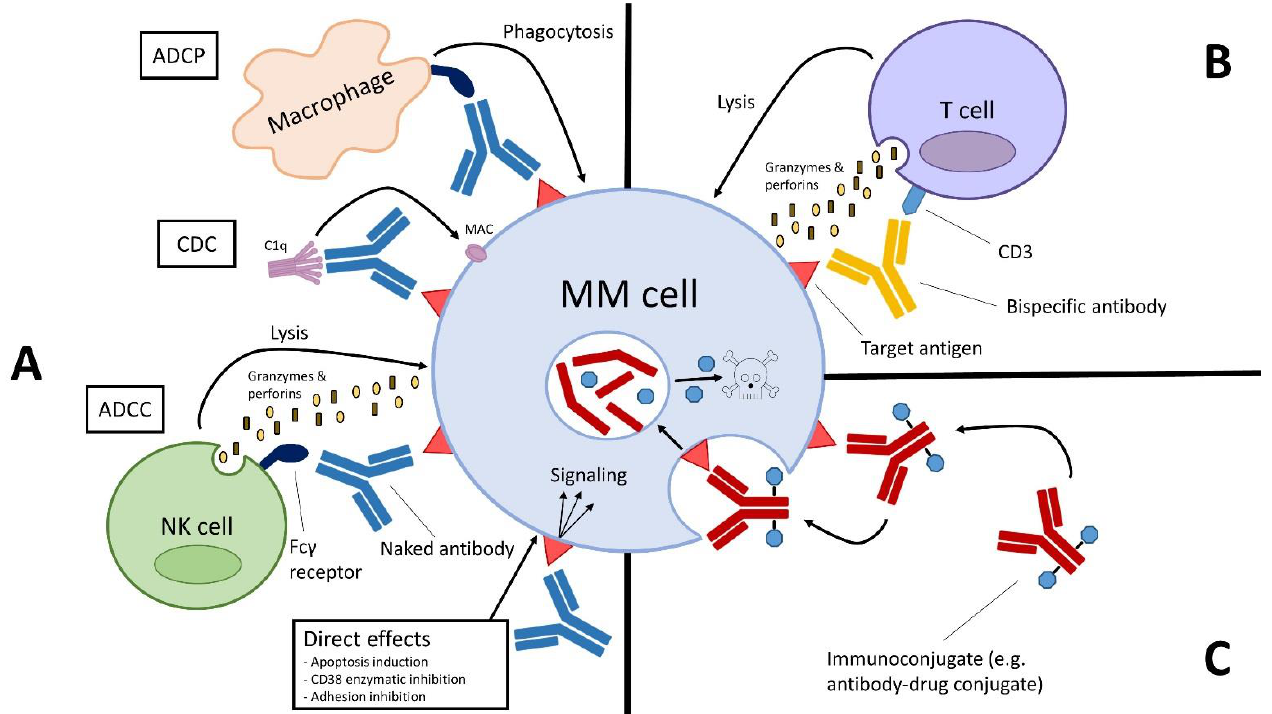
Figure 1. Immunotherapy with antibodies in multiple myeloma. Mode of action of naked antibodies ( A ), bispecific antibodies ( B ), and immunoconjugates ( C ). Abbreviations: MM, multiple myeloma; CDC, complement-mediated cytotoxicity; ADCC, antibody-dependent cellular cytotoxicity; ADCP, antibody-dependent cellular phagocytosis; MAC, membrane attack complex.